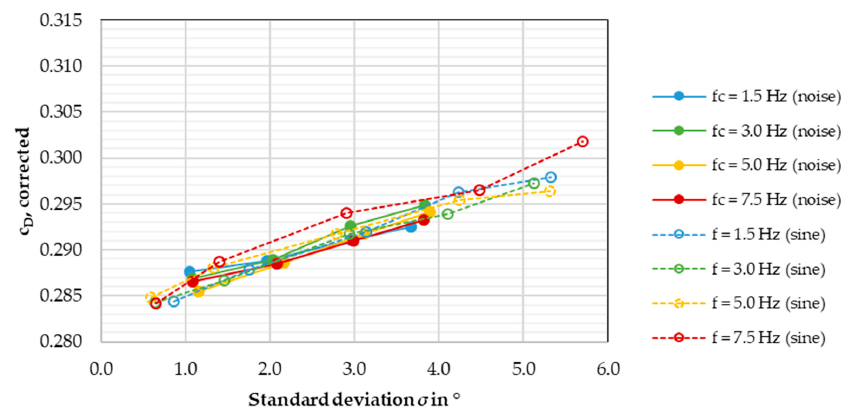
Figure 14. Corrected c D for the DrivAer notchback model, in one diagram.